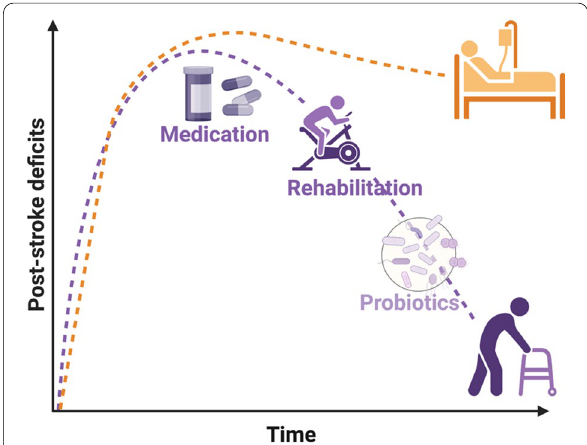
Fig. 2 Potential use of microbiota-targeted therapies for post-stroke recovery. The scheme highlights the potential use of microbiota-targeted therapies such as probiotic therapies as supplementary therapeutic strategies to improve recovery during the chronic phase after stroke. Despite promising preclinical results and first clinical trials, current data is not yet sufficient to prove efficacy of such interventions and to suggest specific compounds or treatment